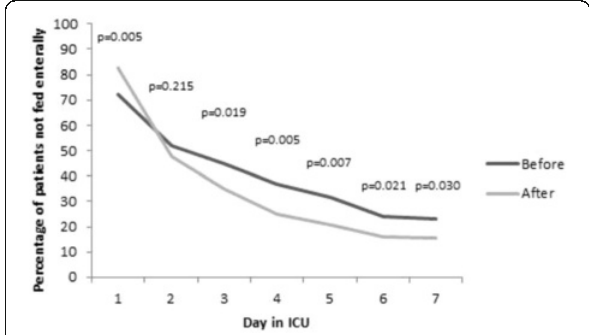
Fig. 24 (abstract A54). Percentage of patients not fed enterally